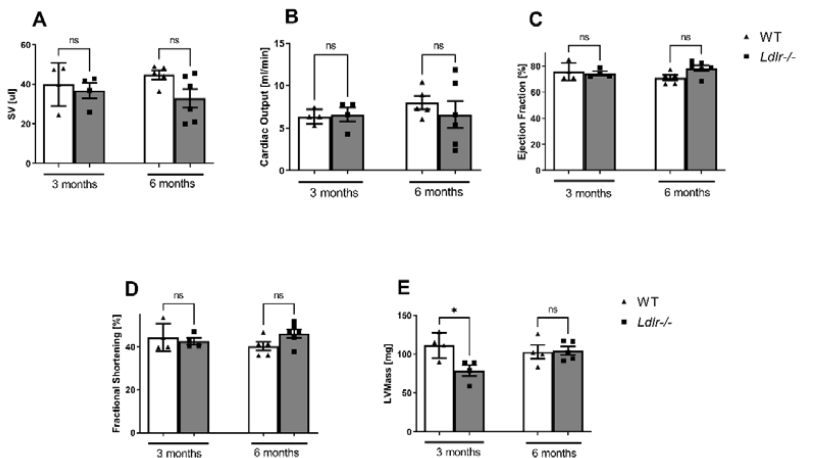
Figure 5. Preserved cardiac function in dyslipidemic Ldlr − / − mice. The echocardiographic examination was performed in 3- and 6-month-old dyslipidemic ( Ldlr − / − ) and control (WT) mice. Stroke volume (SV) ( A ), cardiac output ( B ), ejection fraction ( C ), fractional shortening ( D ), and left ventricular mass (LV mass) ( E ) in 3- and 6-month-old animals, n = 4–6; * p< 0.05 ; ns, non-significant.